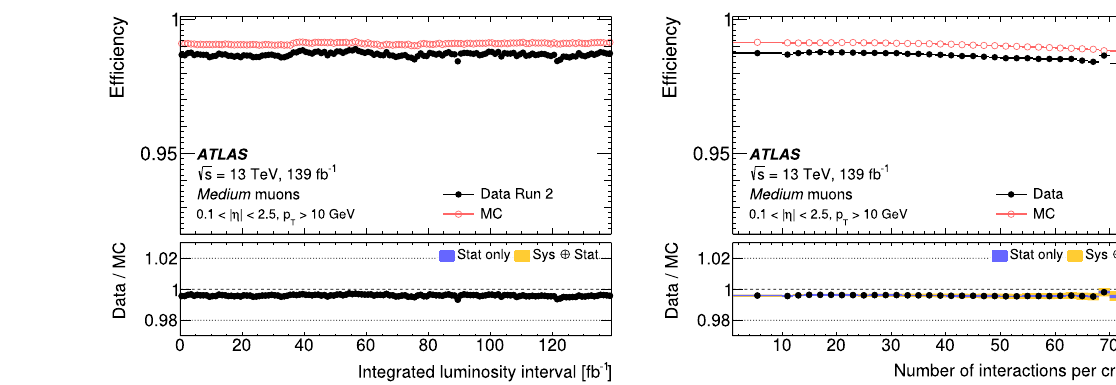
surement is smaller than the size of the markers, and thus not displayed. In the left plot each data point corresponds to 1 fb − 1 of collected data in Run 2. The panel at the bottom shows the ratio of the measured to predicted efficiencies, with statistical and systematic